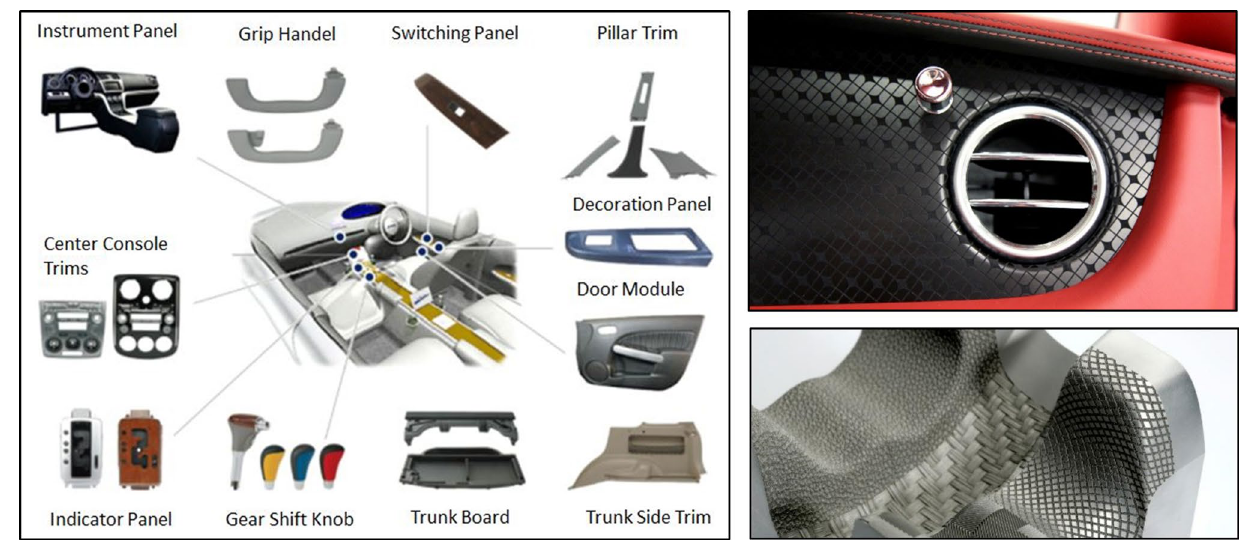
Fig. 4 Applied industry—automotive industry